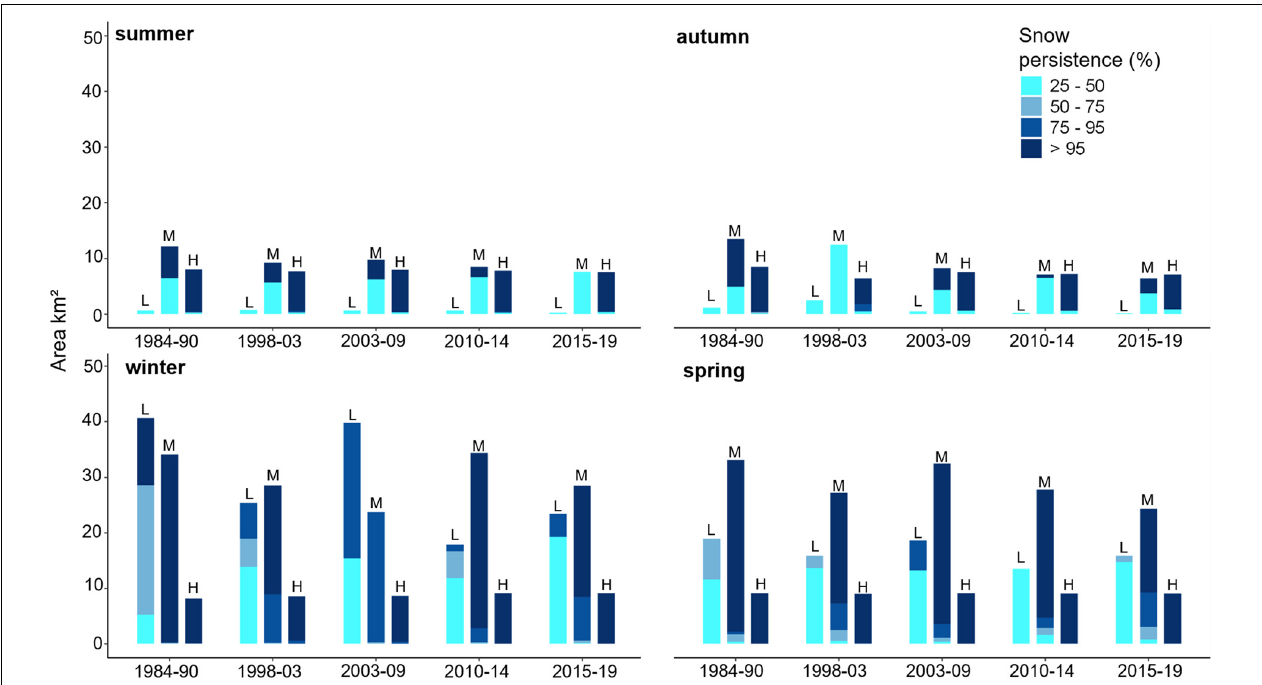
FIGURE 5 | Area changes in snow persistence for different seasons and periods. Bars represent the different elevation belts where L, Low (1,200–1,530 m. a.s.l.); M, Medium (1,530–2,000 m. a.s.l.); and H, High ( > 2,000 m.